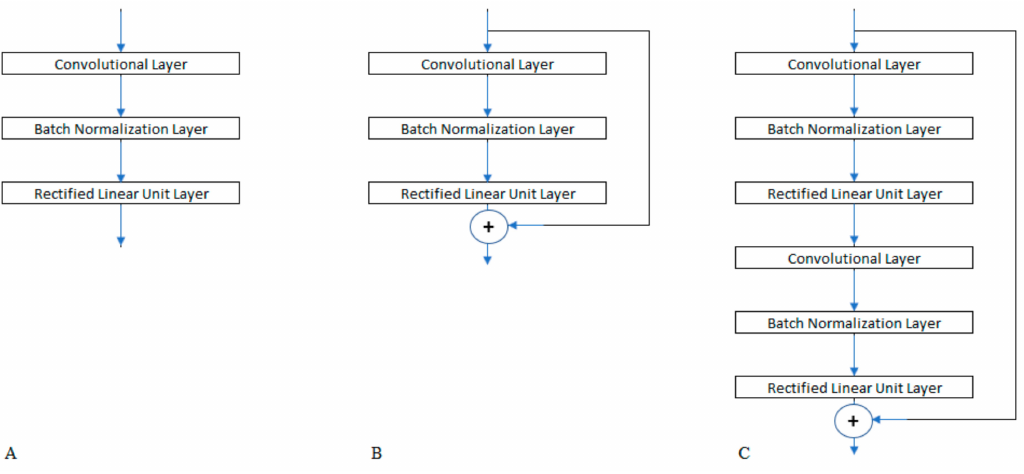
Figure 2. Network stage ( A ) without residual shortcut, ( B ) with residual shortcut for one stage, and ( C ) with residual shortcut for two